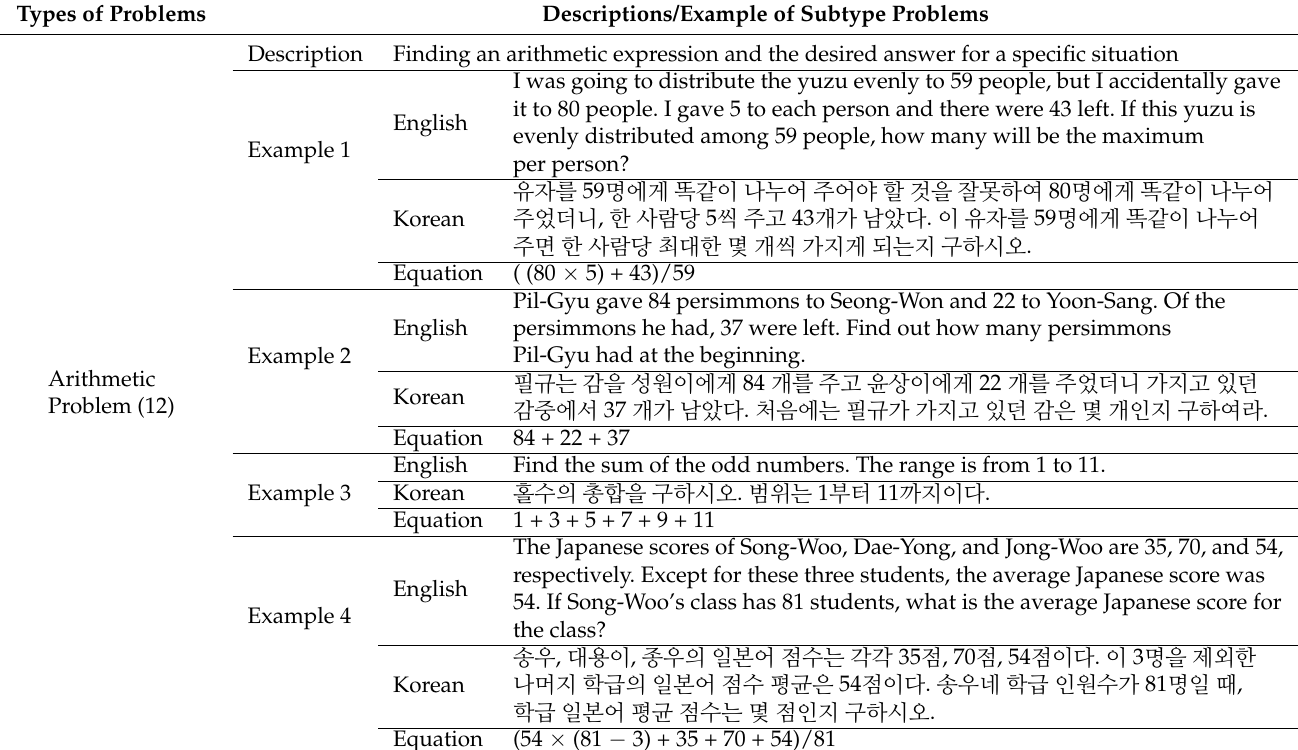
Table 1. Examples of the arithmetic problem